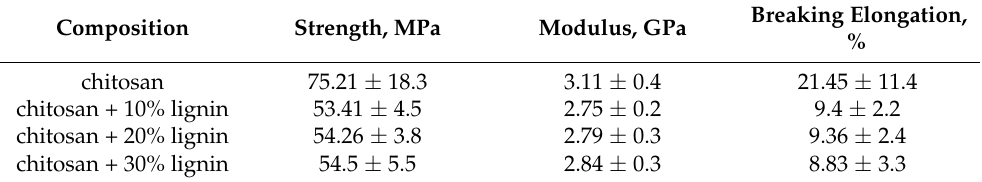
Table 1. Mechanical properties of the studied films in the dry state determined using an Instron 5943 universal testing machinewith the sample base lengthof 20